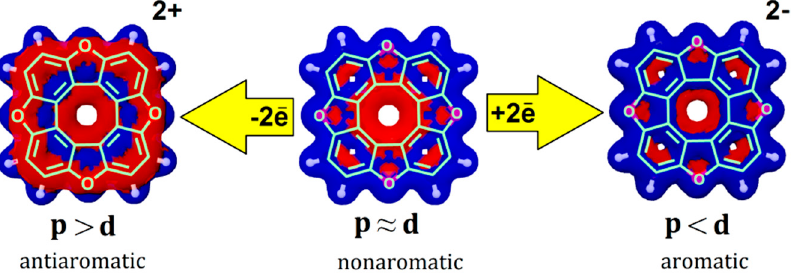
Figure 10. Balance of magnetically induced ring currents in the tetraoxa[8]circulene molecule 10 and its doubly charged ions. Paratropic current densities are shown in red and the diatropic ones are shown in blue.